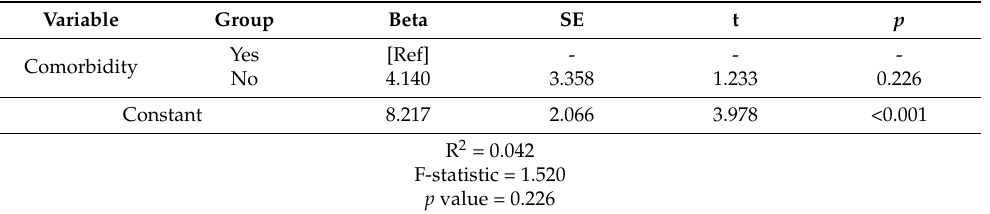
Table 3. Regression analysis results of the effects of comorbidity presence on day of PNX occurrence.